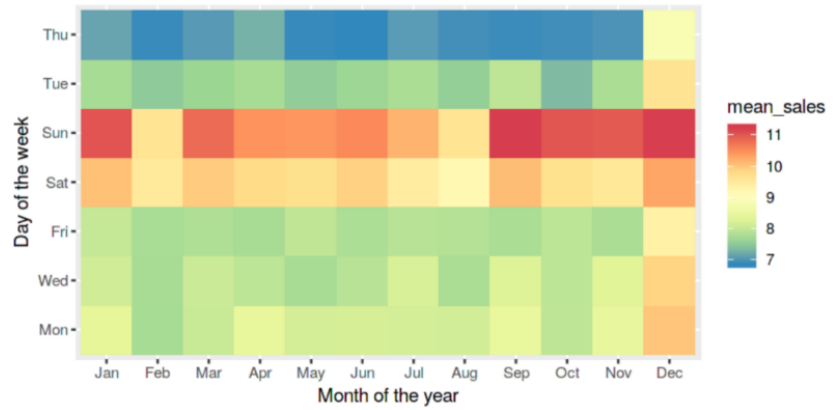
Figure 2. Heatmap generated from the total sales by month and week. Note that the horizontal axis shows the 12 months, the vertical axis shows the period from Monday to Sunday, and the depth of color shows the amount of sales in that area.